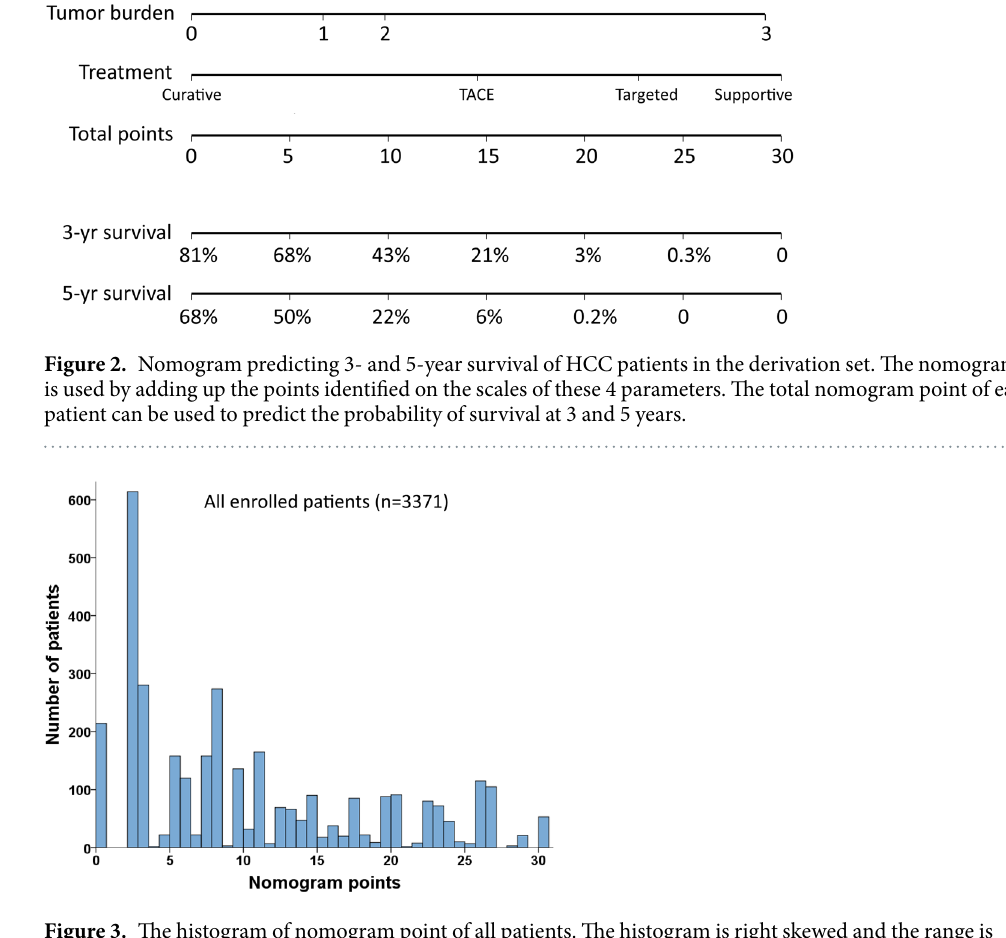
Figure 3. The histogram of nomogram point of all patients. The histogram is right skewed and the range is